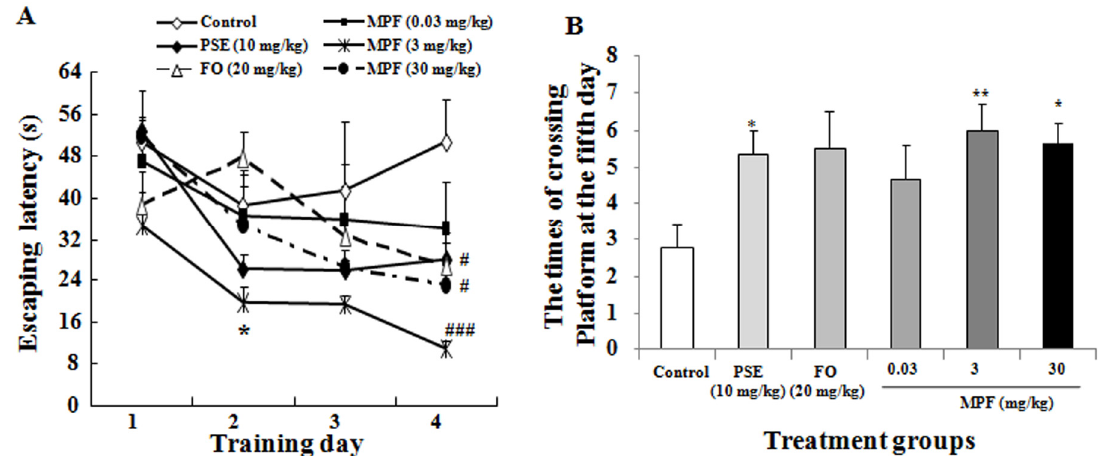
Figure 3. Effects of PSE, FO, and MPF on the spatial memory of mice in vivo . ( A ) Escape latency of mice during the training period in water maze test after administrating PSE, FO and MPF; ( B ) Times of crossing platform after training for 4 days in water maze test after administering PSE, FO and MPF. Water maze test was conducted after sample administration for 5 weeks. Each value represents the mean ± SEM of eight or seven mice. # and ### indicate significant difference relative to the control at the same time point at p < 0.05 and p < 0.001; * and ** indicate significant difference relative to the control at the same time point at p < 0.05 and p < 0.01, respectively.